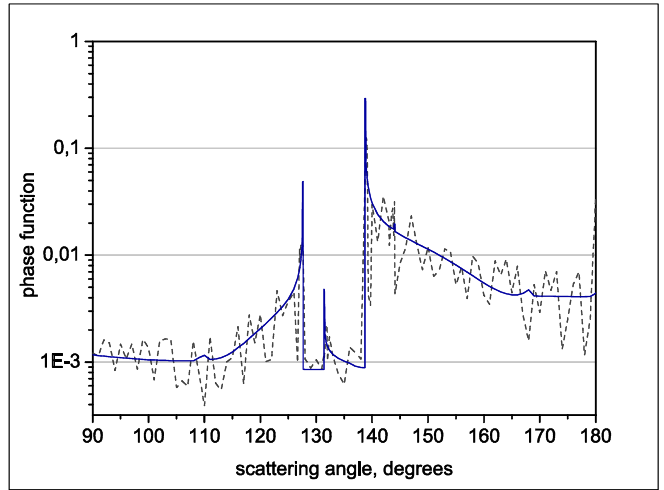
Figure 2. Part of the phase function around rainbows calculated using the geometric optics approach (GOA) (solid line) and the Mie theory (dashed line) for the water drop (diameter D = 1 mm, wavelength λ = 0.412